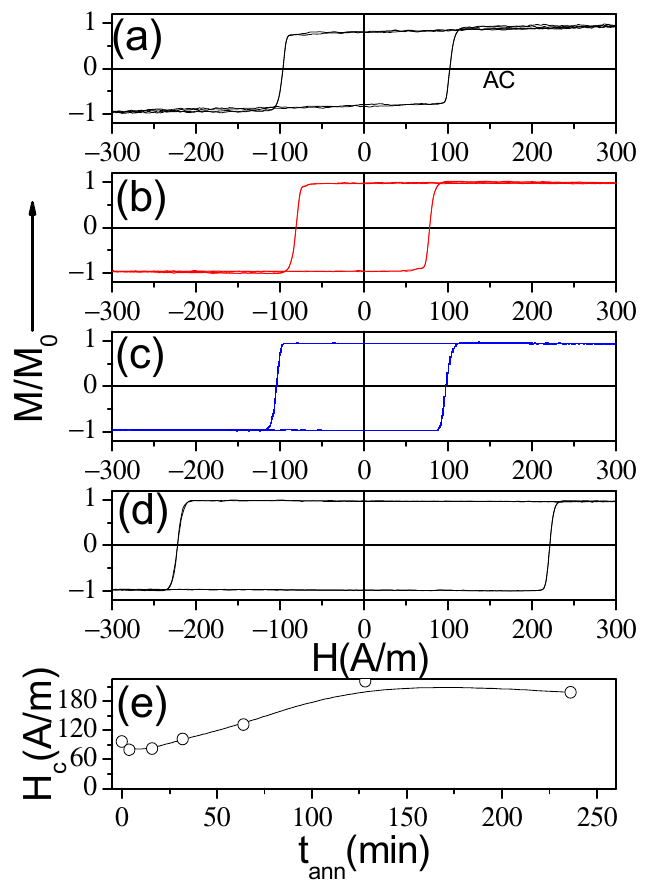
Figure 11. Hysteresis loops of as-prepared ( a ) and annealed at T ann = 410 °C for t ann = 4 min ( b ) 32 min( c ) 128 min ( d ) and H c ( t ann ) dependence ( e ) for Fe 49.6 Ni 27.9 Si 7.5 B 15 microwires. (Reproduced with permission from [81] Copyright © 2020 AIP Publishing LLC, Open Access).